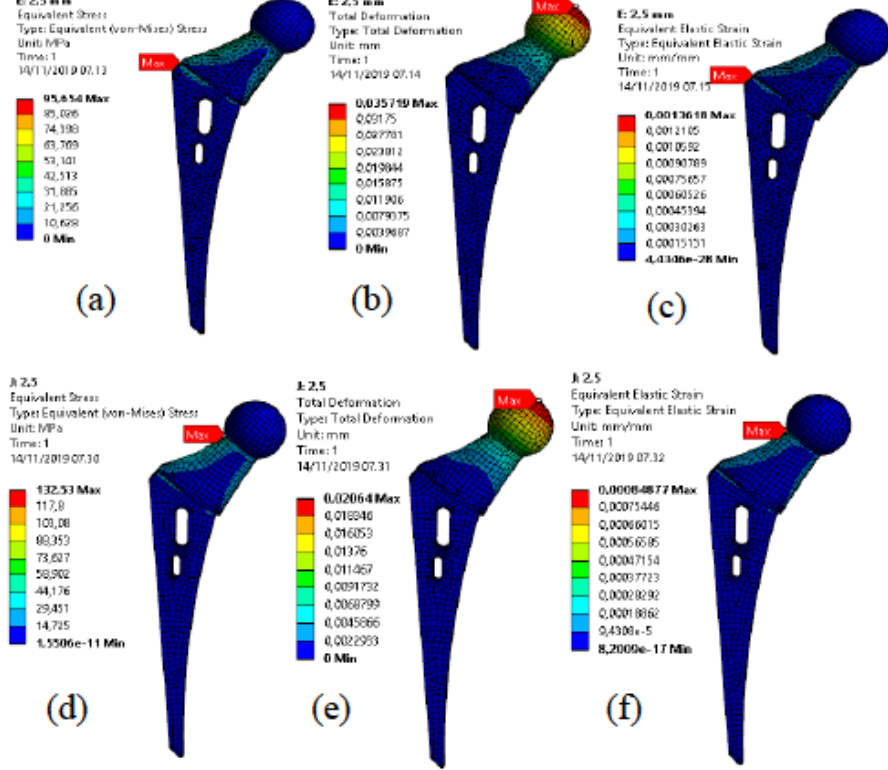
Figure 12: For element size 2,5 mm on Ti-6Al-4V (a) Stress (von misses), (b) deformation, (c) strain (von misses) and on SS 316 L 4V (d) Stress (von misses), (e) deformation, (f) strain (von misses)